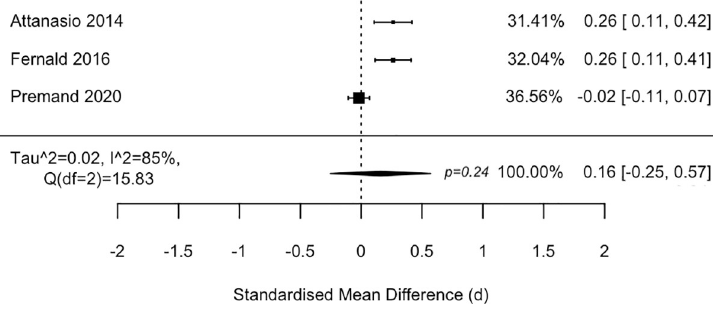
Fig 6. Forest plot of Cash + Psychosocial Stimulation vs. cash alone on cognitive